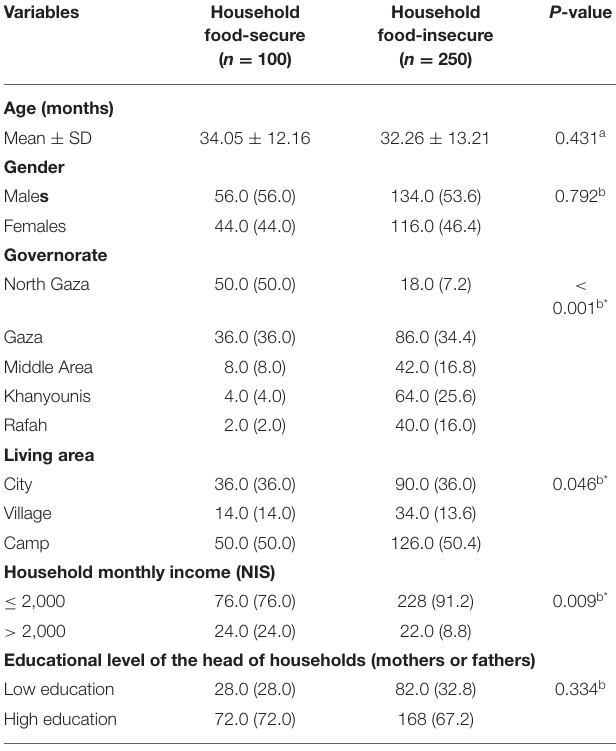
TABLE 1 | Demographic socioeconomic characteristics of under-five children by household food-security status ( n = 350).